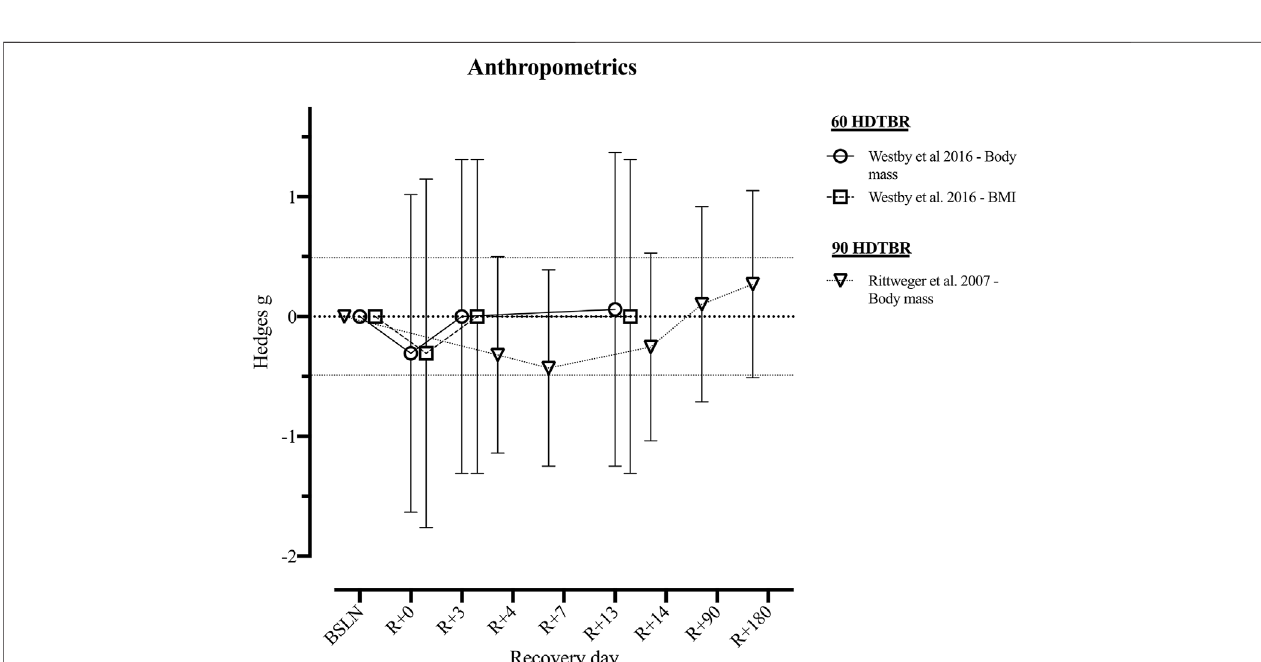
FIGURE2| Visualisationoftherecoveryofoutcomesrelatedto ‘ Anthropometrics Outcomes ’ afteraperiod ofhead-down-tiltbedrest,displayed asHedges g with 95%Con fi denceInterval. Todetermine whether aparticular outcome could bedeemed as “ recovered ” during therecordedrecoveryperiod,theWestlake ’ sCon fi